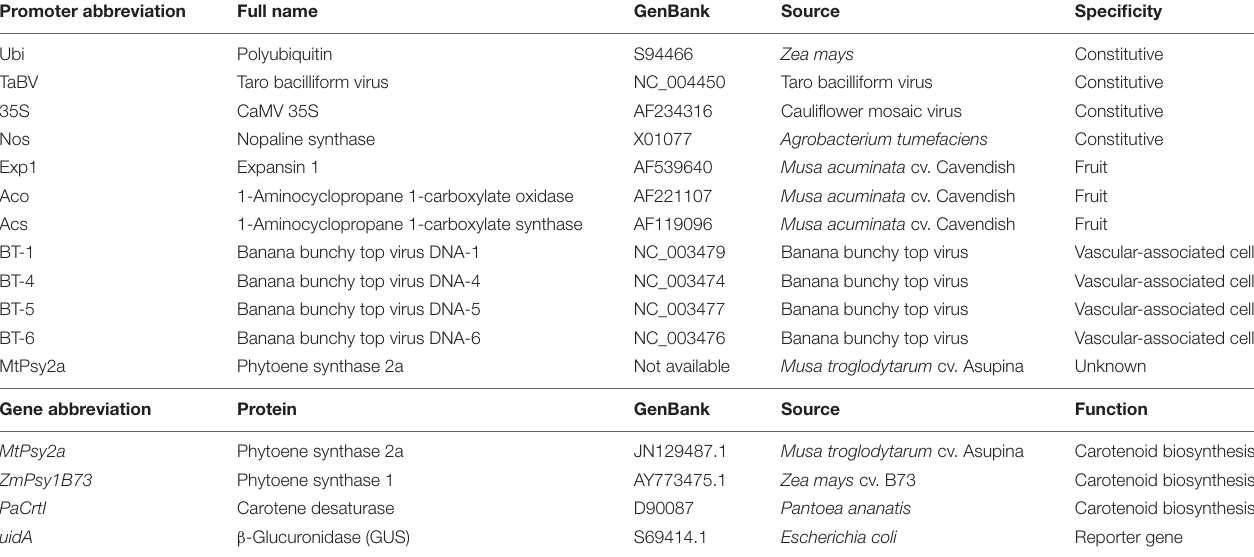
TABLE 1 | List of promoters and genes tested in AFT-1 of the Banana21